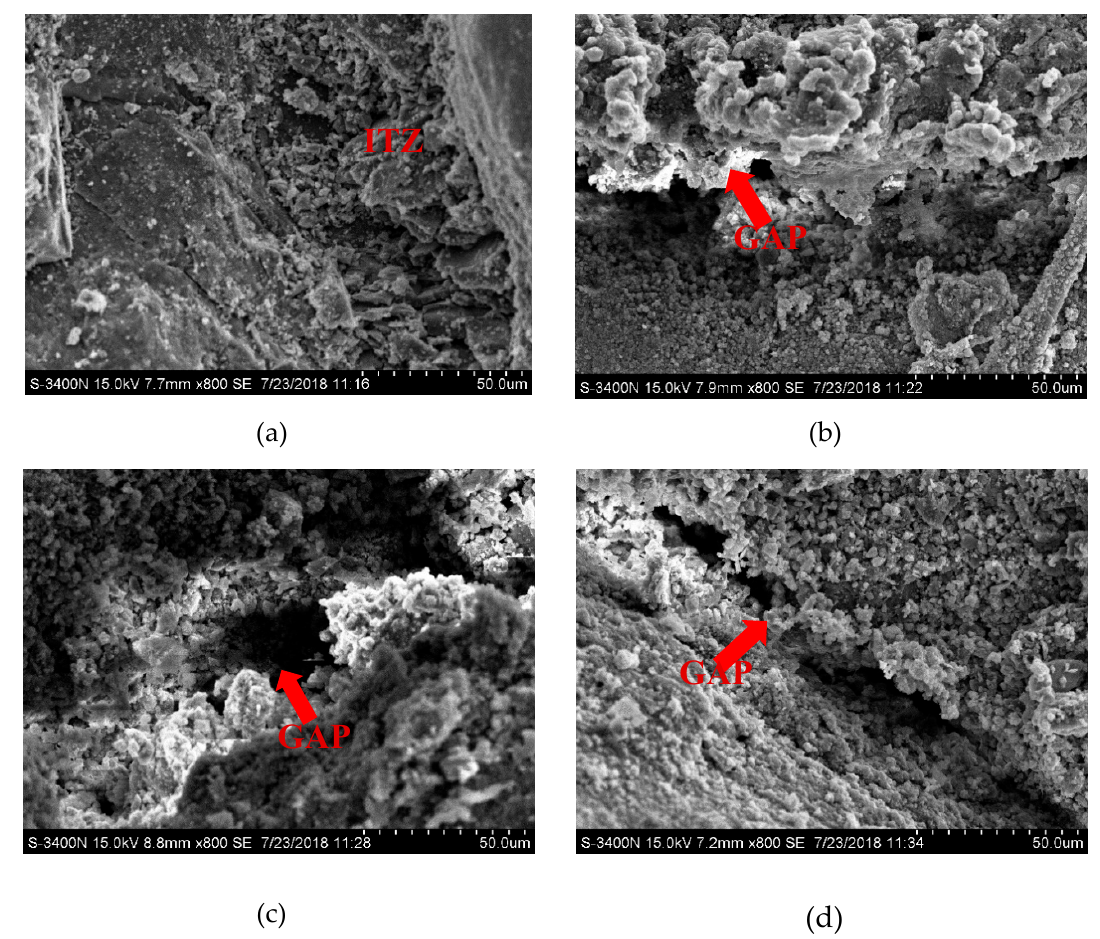
Figure 10. SEM images of rubberized mortar interfacial transition zones (ITZ). ( a ) ITZ of the sand and cement paste; ( b ) ITZ of Rubber A and cement paste; ( c ) ITZ of Rubber B and cement paste; ( d ) ITZ of Rubber C and cement paste.